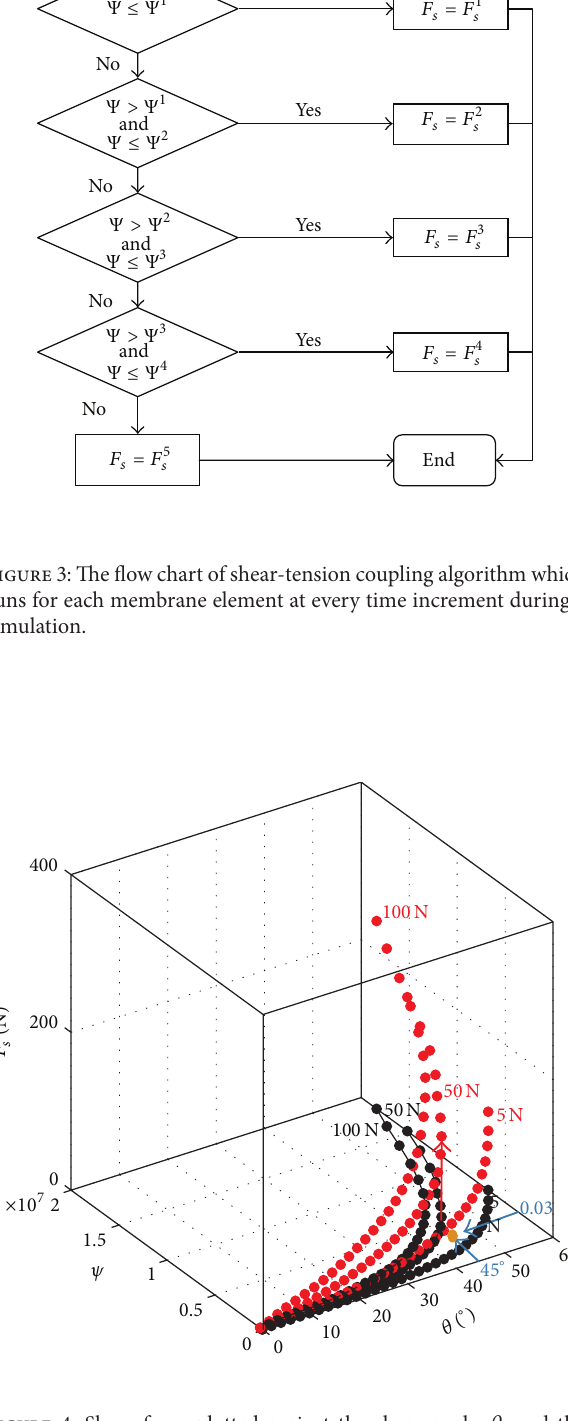
Figure 4: Shear force plotted against the shear angle, 𝜃 , and the average fibre strain, 𝜓 . Black lines indicate the average tensile strain versus shear angle polynomial curves plotted in ( 𝜃 , 𝜓 ) 2-D space, and red lines indicate the corresponding shear force versus shear angle curves, plotted in the (𝜃, 𝜓,𝐹 𝑠 ) 3-D